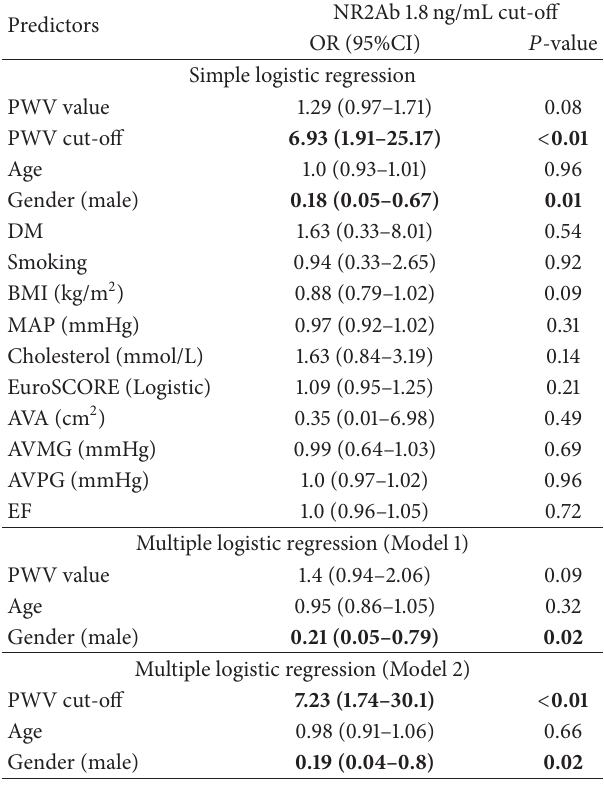
Table 3: Simple and multiple logistic regression analysis to identify variables that independently predict patients with high NR2Ab (NR2Ab 1.8ng/mL